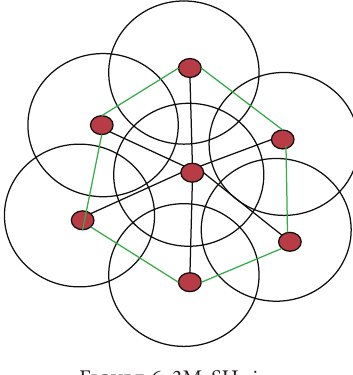
Figure 6: 3MeSH ring.